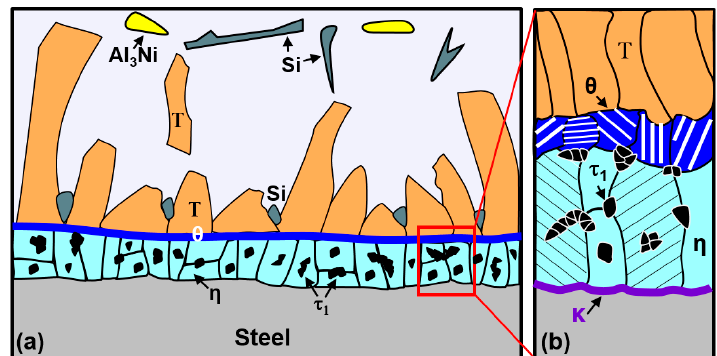
Figure 11. Schematic diagram of the distribution of phases in the solidification and reaction layers.